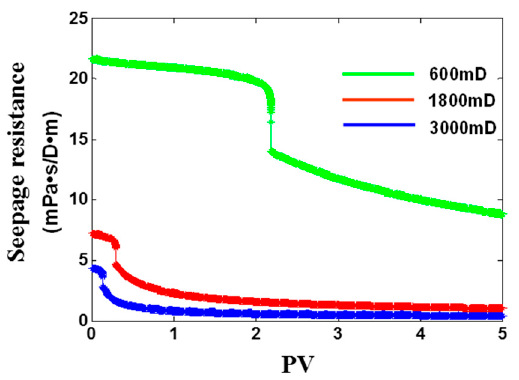
Figure 5. Comparison of the seepage resistance with different permeability in each layer of the planar radial flow model ranging from 0 to 5 pore volume (PV).